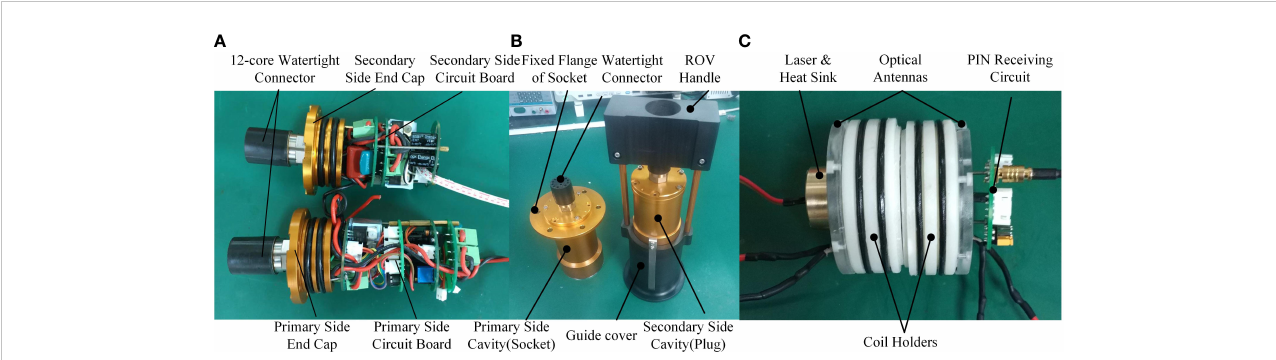
FIGURE 8 Assembled prototype of OCPT-NWMC [ (A) Assembly of circuits and end caps (B) assembly of the connector (C) Assembly of Optical System and Loosely Coupled Coils].